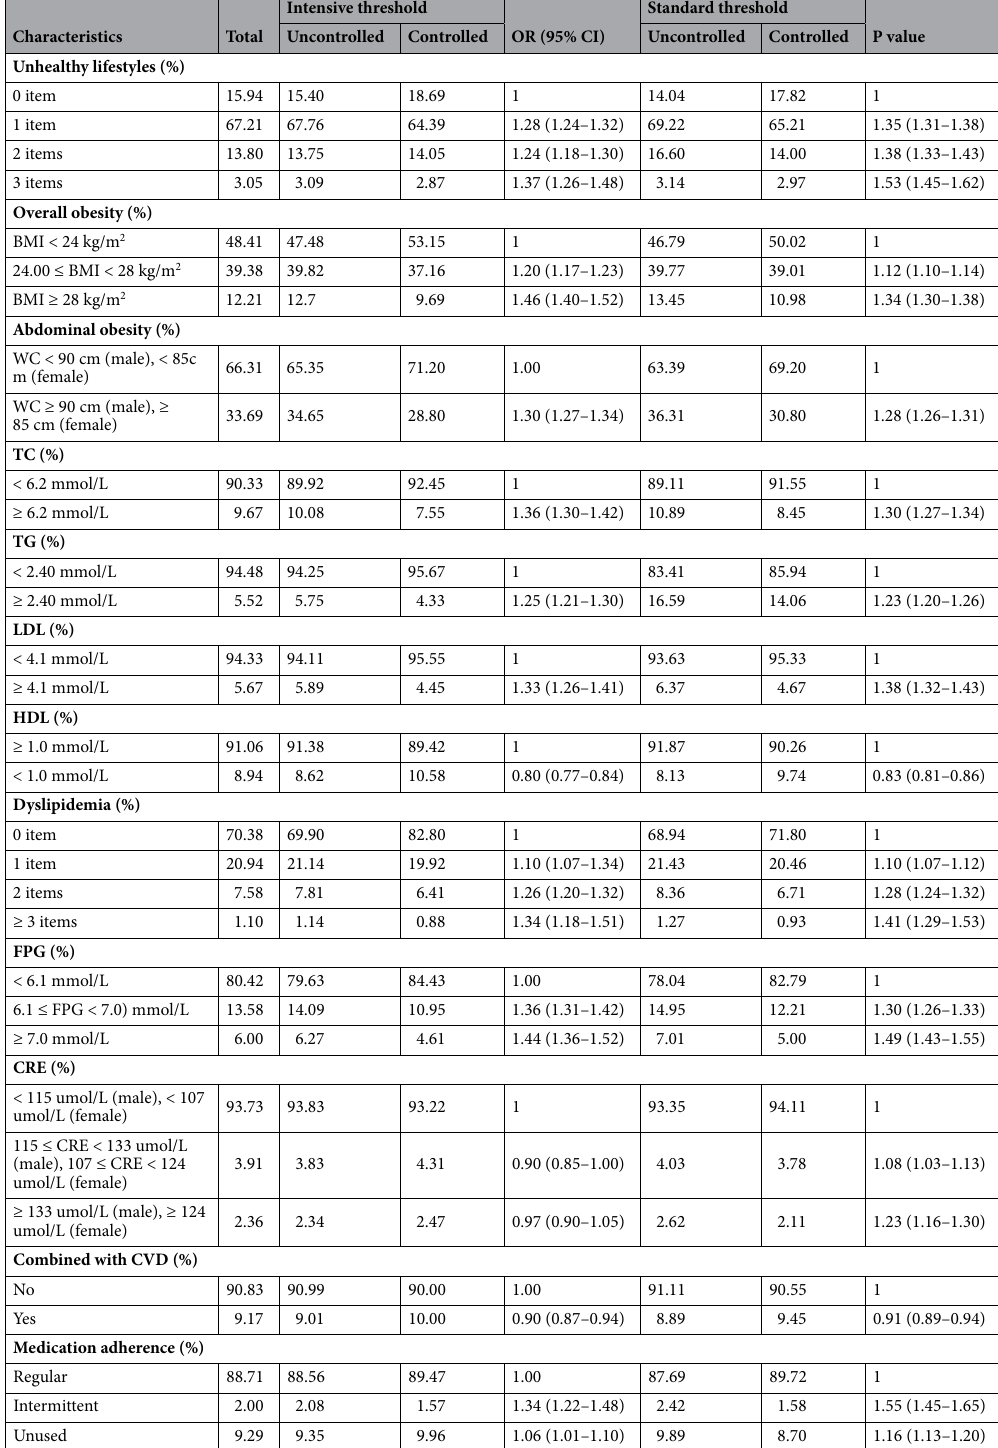
Table 2. The proportion and hazard of cardiovascular factors, combined CVD and medication adherence. Note, age and sex was considered as adjusted variables in Logistic